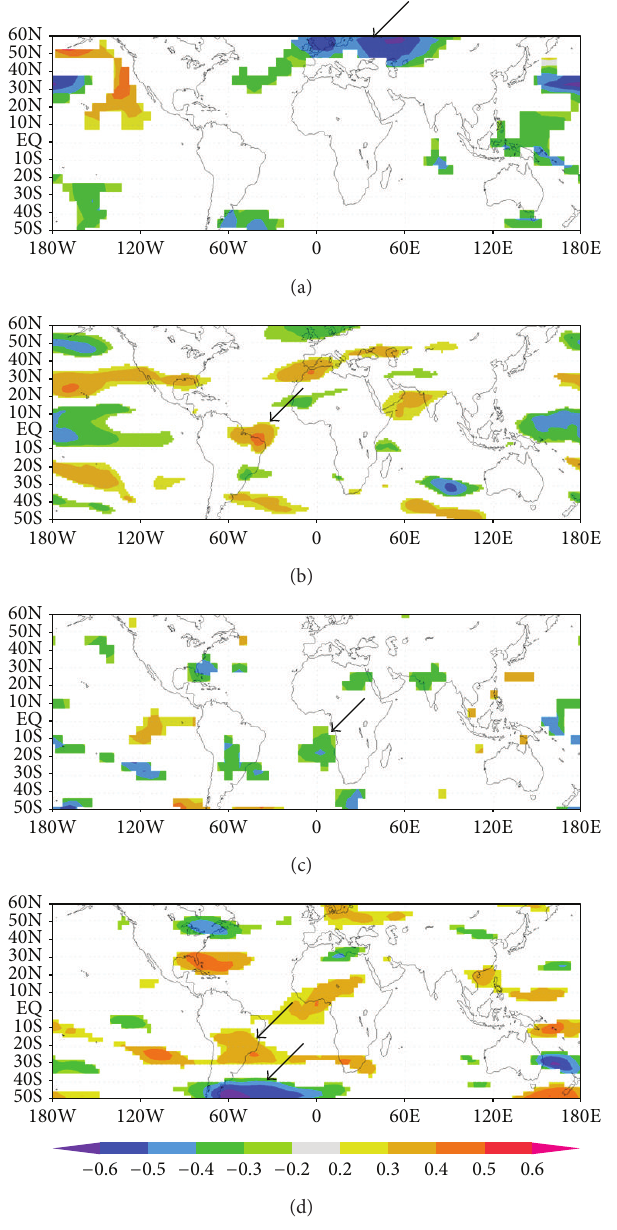
Figure 4: Correlation of MJJ southern rain with DJF (a) Ts and (b) 850 U fields 1983–2012. Correlation of ASO southern rain with MAM predictors: (c) Ts, and (d) 200 U fields for GPCC6 rain 1981– 2010.